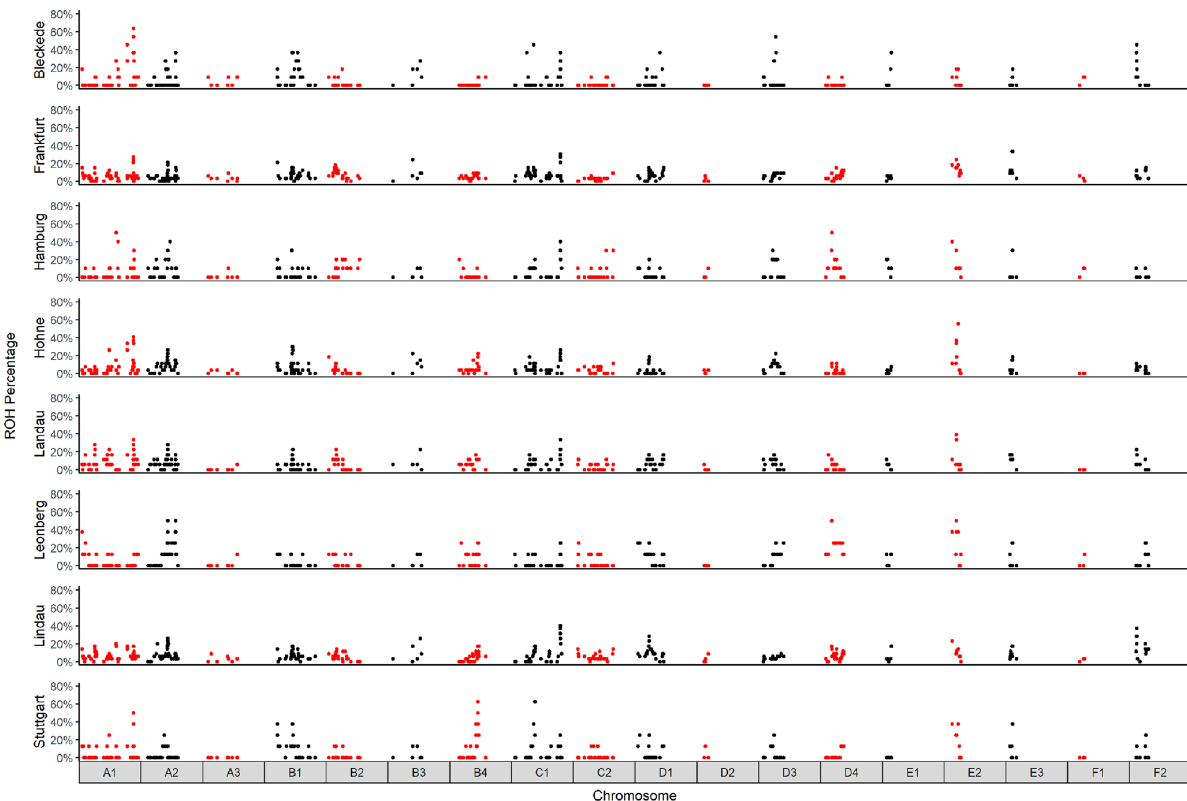
Figure 8. Distribution of partial consensus ROHs in stray. Shown are the distributions of ROH percentages in eight stray subpopulations across all autosomes. The alternating red and black ROH percentages are from neighboring